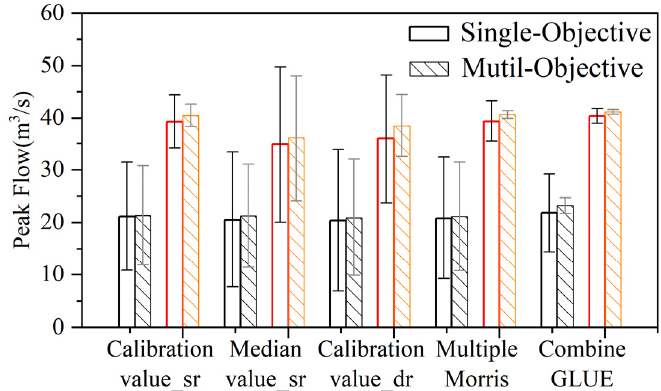
Figure 7. Error charts for single-objective versus multi-objective constraint algorithms in model flow simulation. Each name corresponds to two groups of two bar charts; the group of bar charts on the left corresponds to the top peak of rainfall event 0819, and the group of bar charts on the right corresponds to the top peak of rainfall event 0515. The length of the vertical lines on the bar graphs represents the peak relative error of the model simulation.